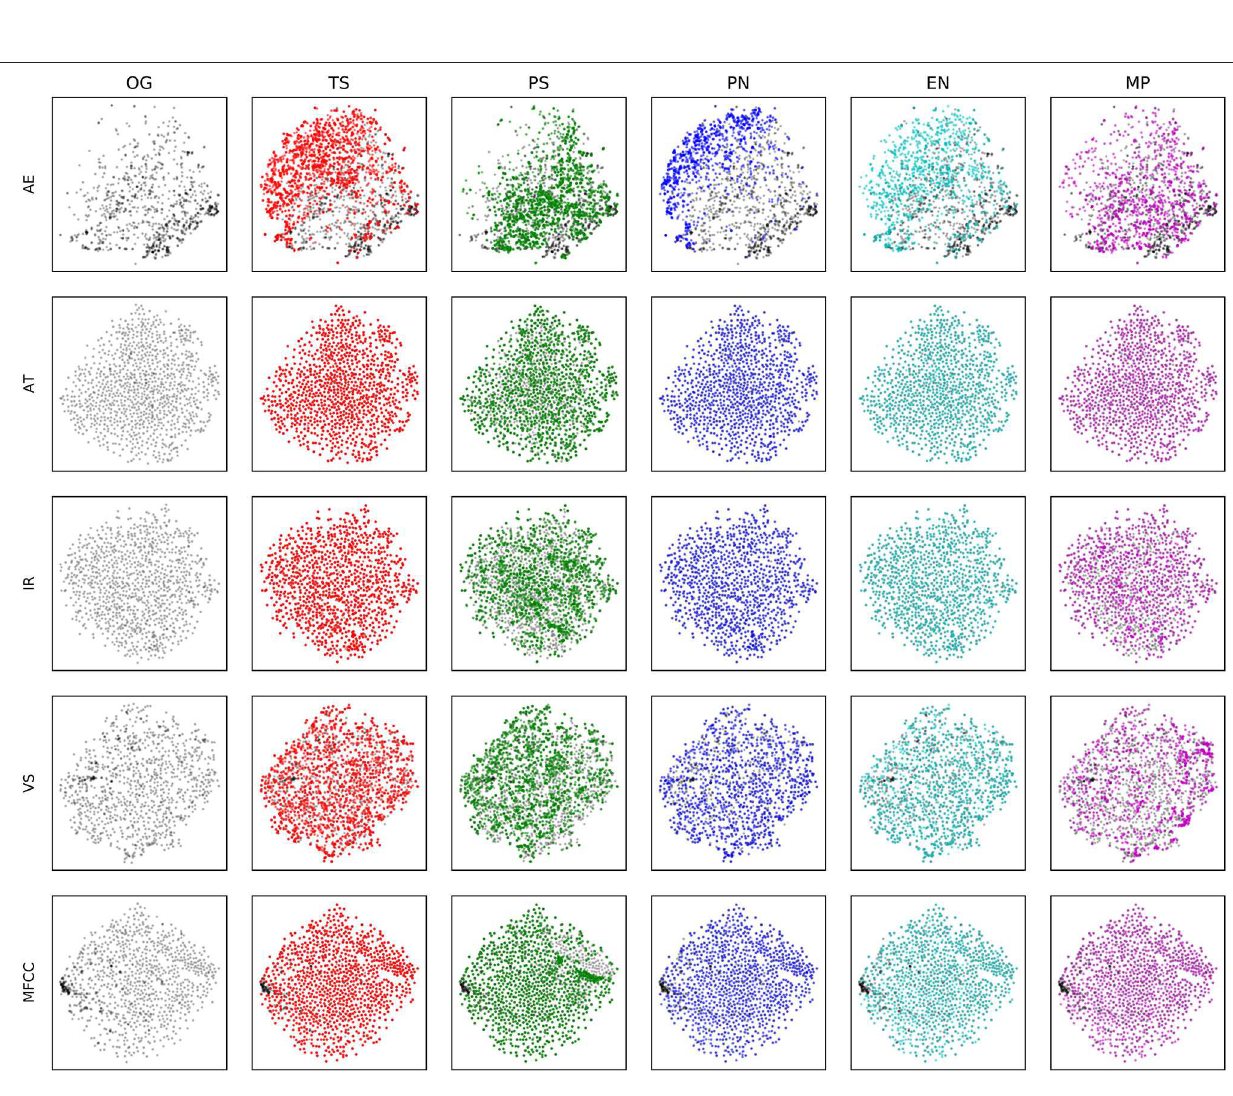
FIGURE 9 | Scatter plot of encoded representations and their transformations for baseline MFCC and f encoders with respect to the tasks we investigated. For all panes, black points indicate original audio samples in the encoded space, and the colored, overlaid points indicate the embeddings of transformations according to the indicated